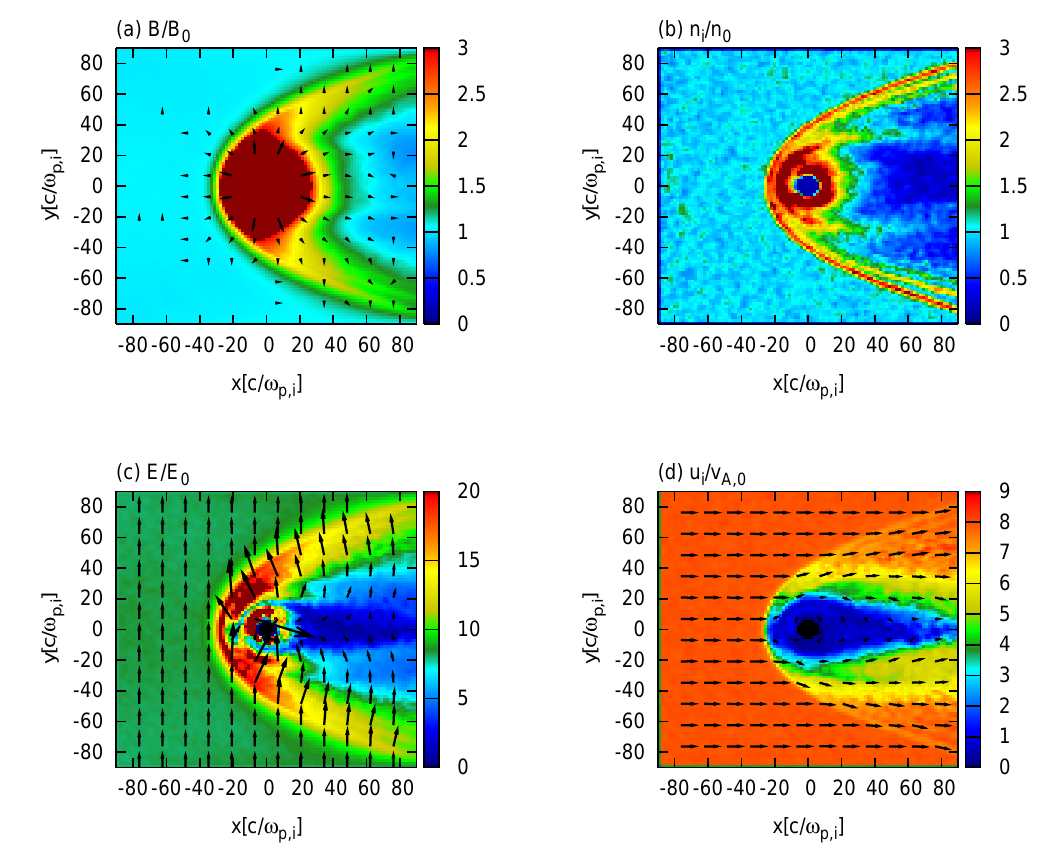
Fig. 4. Antiparallel orientation of B SW and M – Cut through the (x,y) plane of the simulation box. The figure displays (a) the magnetic field, (b) the mean plasma density, (c) the electric field and (d) the mean ion velocity. All quantities are normalized as described in the caption of Fig. 2. As can be seen from panel (b), the boundary layer surrounding the interaction region develops some kind of substructure. The outer curve denoting an increase of plasma density is followed by a second one and finally by a third one. Besides, a belt of temporarily trapped particles is formed in the equatorial plane of the obstacle. The origin of these structures can be explained by analyzing the dynamics of individual